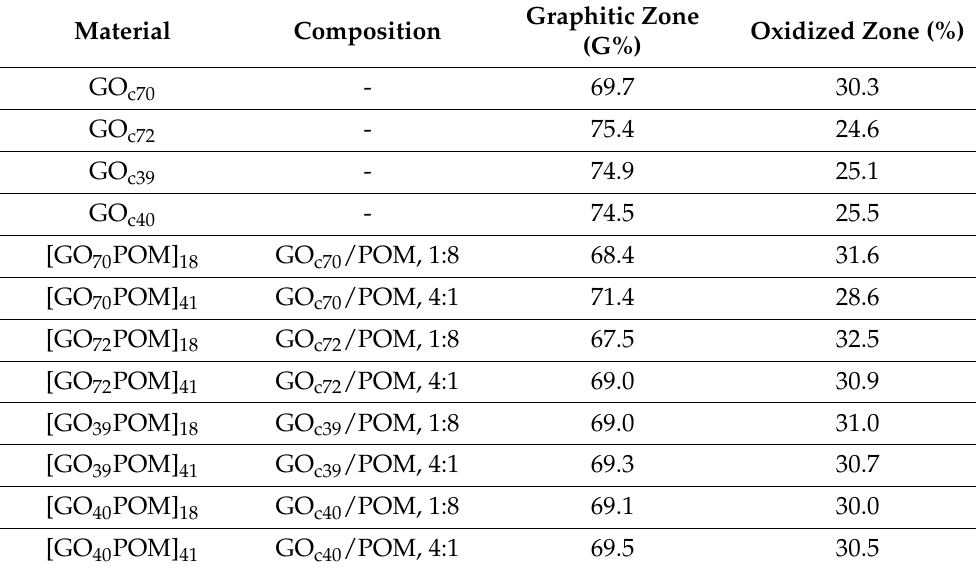
Table 4. The sp 2 /sp 3 carbon cluster on each composite